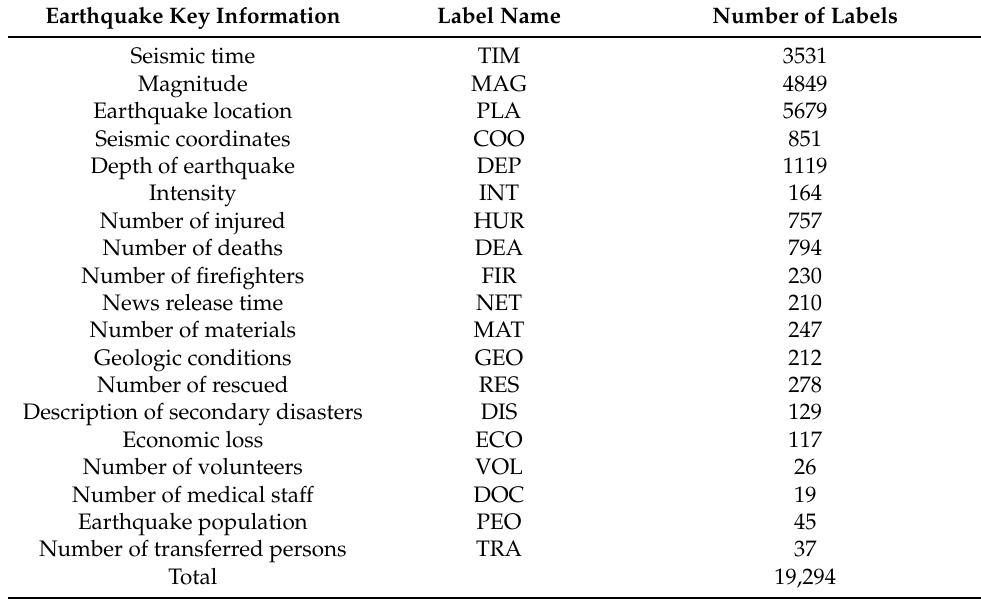
Table 1. Earthquake information labeling table. Earthquake Key